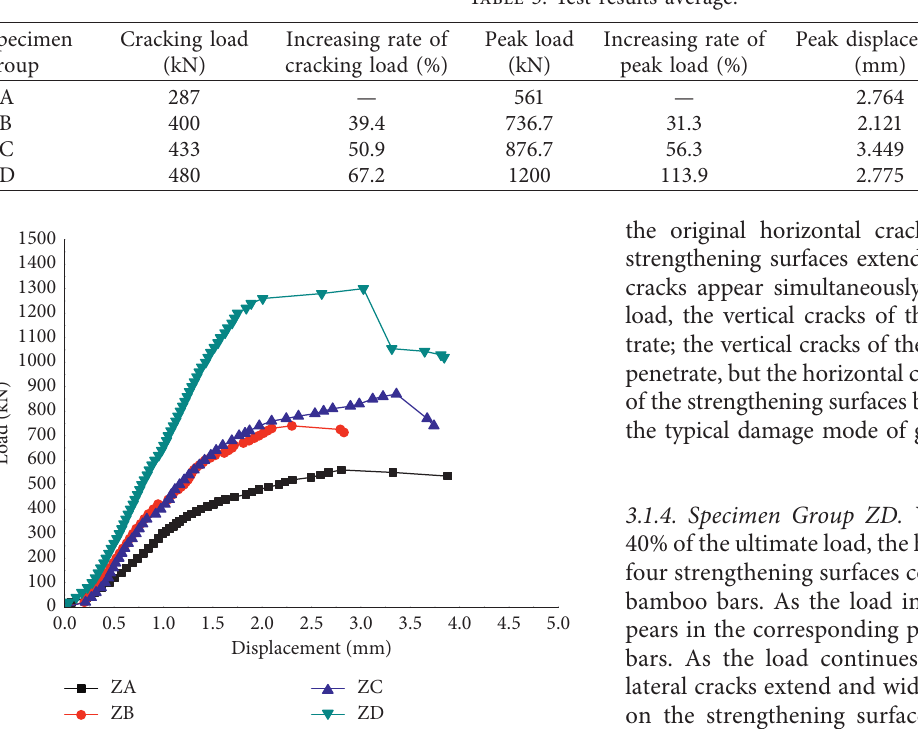
Figure 5: Load-displacement curves of typical